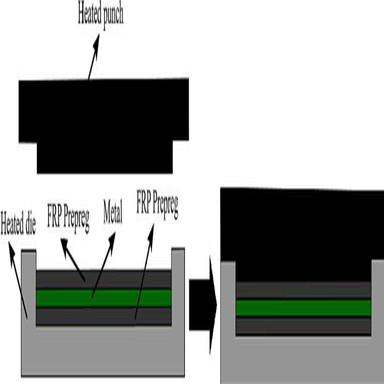
Intrinsic manufacturing process for fabricating the FPR/metal hybrid composites.